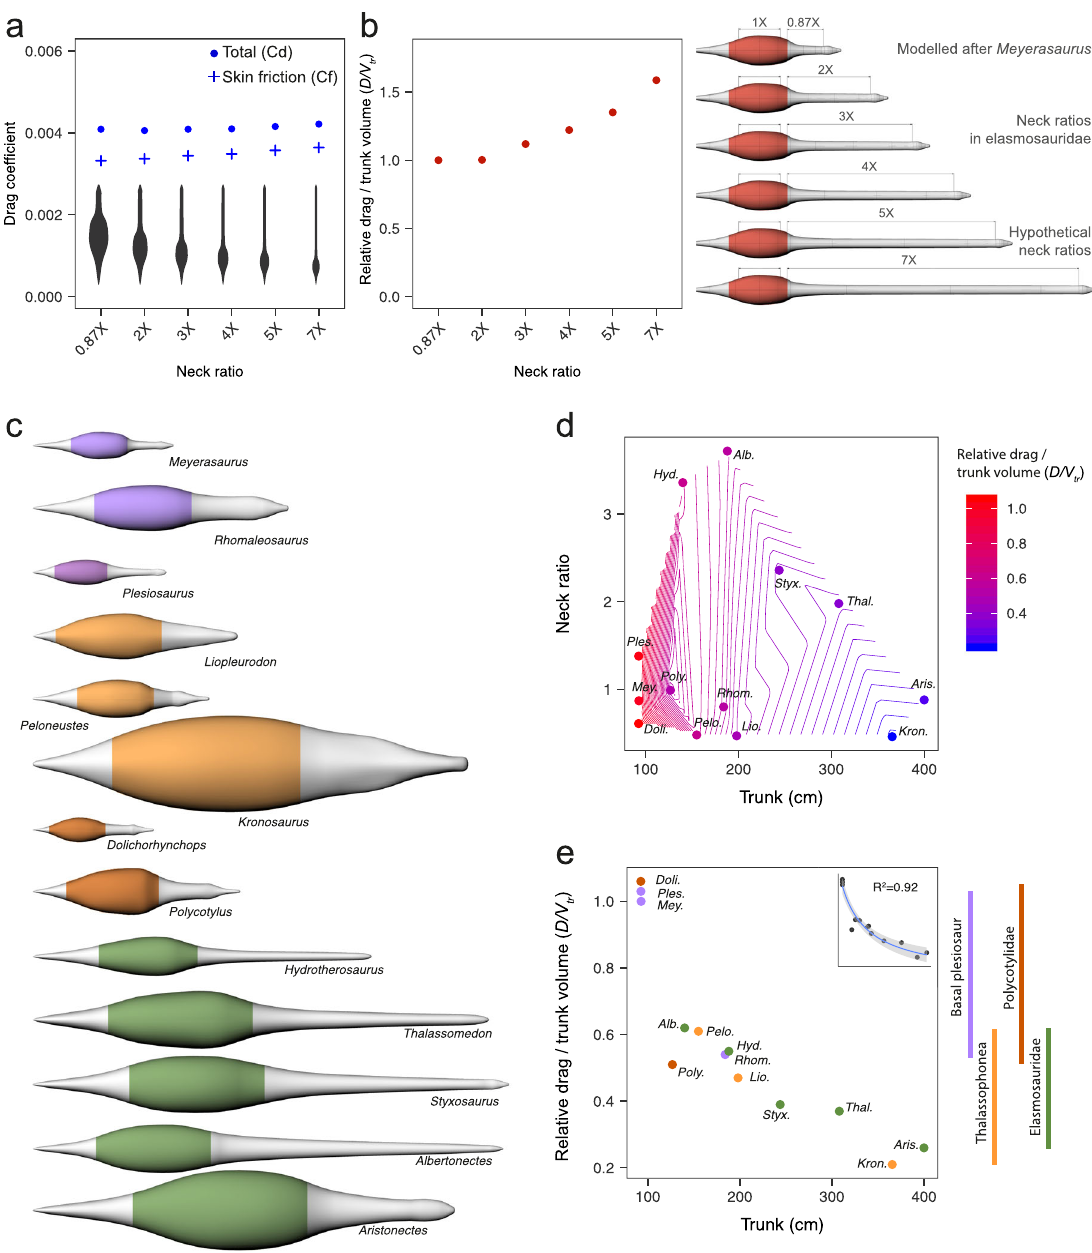
Fig. 4 In fl uence of neck length and its interaction with body size on the drag-related costs of swimming in plesiosaurs. a Total drag coef fi cient and skin friction drag coef fi cient for an array of hypothetical plesiosaurs with varying neck ratios computed at Re = 5 × 10 6 (same total length and in fl ow velocity). b Drag per unit of trunk volume computed for the same array of models scaled at the same trunk length and tested at the same speed of 1 ms − 1 . The hypothetical models were created by modifying the length in the model of the basal plesiosaur Meyerasaurus victor which has a neck ratio of 0.87×. The limits of the trunk (which extends along the torso and includes the edges of the pectoral and pelvic girdles) are shown in red in the rendered models. c Three-dimensional models of a wide array of plesiosaurs, in dorsal view, at their life-size dimensions, showing the differences in body proportions and sizes. The limits of the trunk in the models (de fi ned as in b ) are coloured by group. Basal plesiosaurs are highlighted in purple. Among the derived groups, thalassophonean plesiosaurs (derived pliosaurid plesiosaurs) are highlighted in light orange, polycotylid plesiosaurs in dark orange and elasmosaurid plesiosaurs in green. d Scatterplot of trunk length (cm) and neck ratio showing the relative drag per unit of trunk volume as a gradient of colour for each taxon analysed and for the plot area in between (contour lines represent the interpolated values of drag per unit of volume). e Plot of the relative drag per unit of trunk volume versus the trunk length showing results highlighted by group. Line plots at the right-hand side show the range for each group. The D/V tr and the trunk length show a signi fi cant negative correlation (Pearson ’ s correlation coef fi cient calculated with log-transformed variables, p = 2.28 × 10 − 7 , R 2 = − 0.92). A small version of the fi tted power curve (regression equation y ¼ 69 : 76 x (cid:2) 0 : 94 ) is shown on the right upper corner. The grey area around the curve represents a con fi dence interval of 95%. All values in b , d and e are normalized to the results for the Meyerasaurus